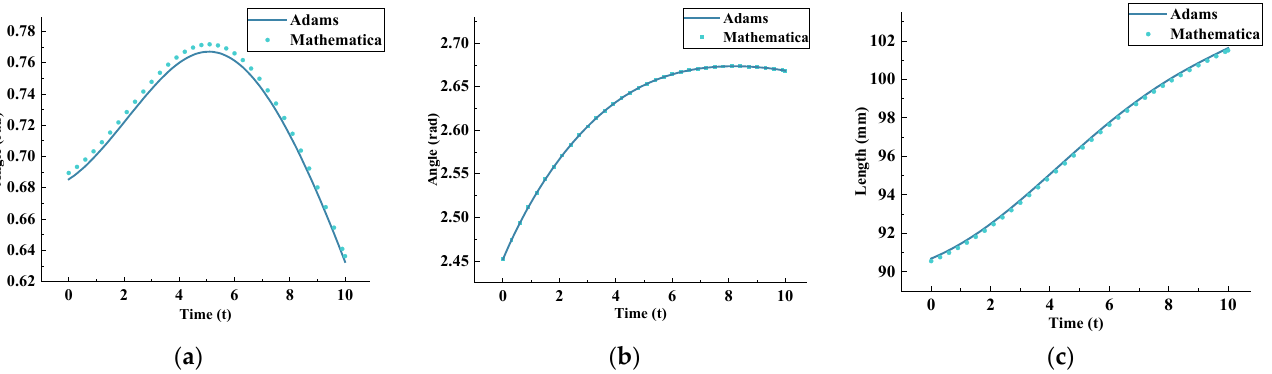
Figure 4. Comparisons of inverse kinematics theory and simulation results: ( a ) ϕ ; ( b ) φ ; ( c ) h 3 .